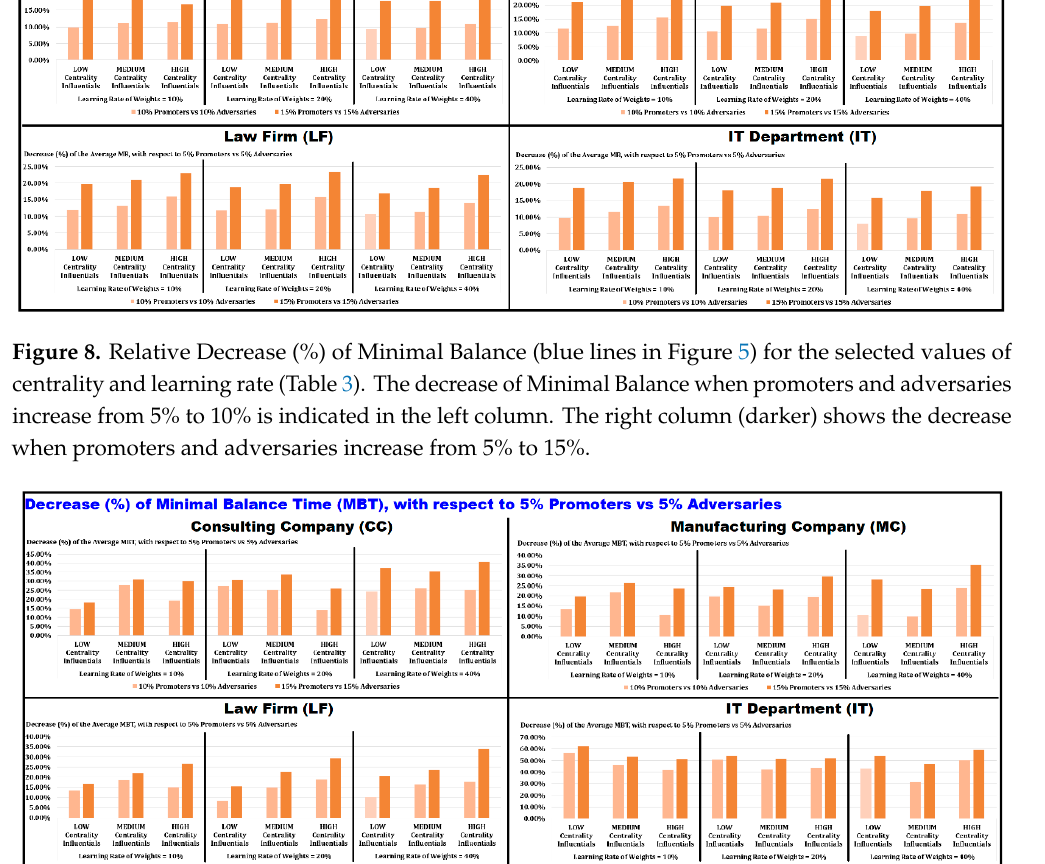
Figure 9. Relative Decrease (%) of Minimal Balance Time (green line in Figure 5) for the selected values of centrality and learning rate (Table 3). The decrease of Minimal Balance Time when promoters and adversaries increase from 5% to 10% is indicated in the left column. The right column (darker) shows the decrease when promoters and adversaries increase from 5% to 15%.